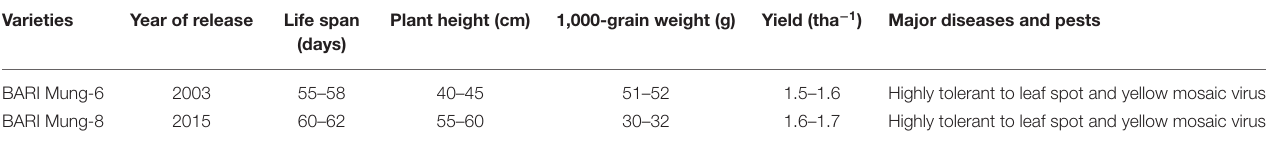
TABLE 2 | Properties of existing V. radiata varieties used in the present experiment [Bangladesh Agricultural Research Institute (BARI), 2019].